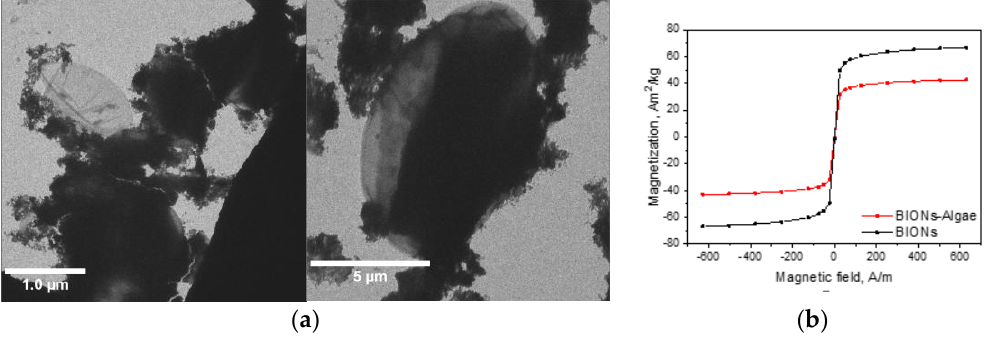
Figure 2. ( a )Transmission electron microscopy pictures of BIONs and S. ovalternus after binding. The BION/microalgae mass ratio was 0.3 g/g at pH 6.75. ( b ) Saturation magnetization data of BIONs after binding to S. ovalternus for a BION/microalgae mass ratio of 1.5 g/g. The saturation magnetization of the BIONs before incubation with the microalgae is added as reference.